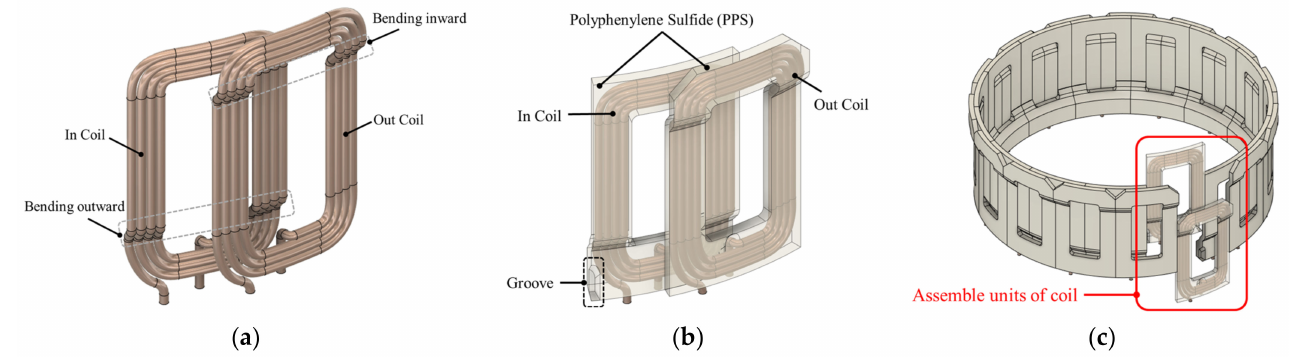
Figure 2. Structure concept of slotless winding: ( a ) coil; ( b ) units of coil; ( c ) assembled units of coil.